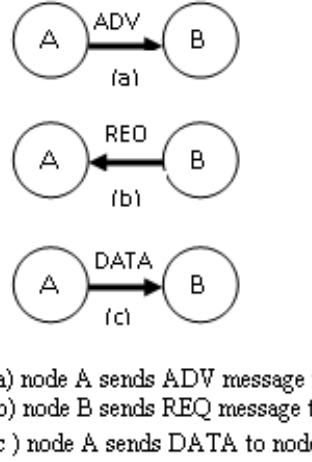
Figure 5. Data Transmission in